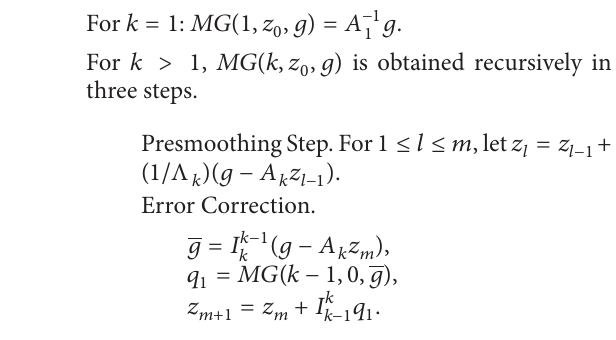
Algorithm 13 (the 𝑘 th level V-cycle multigrid